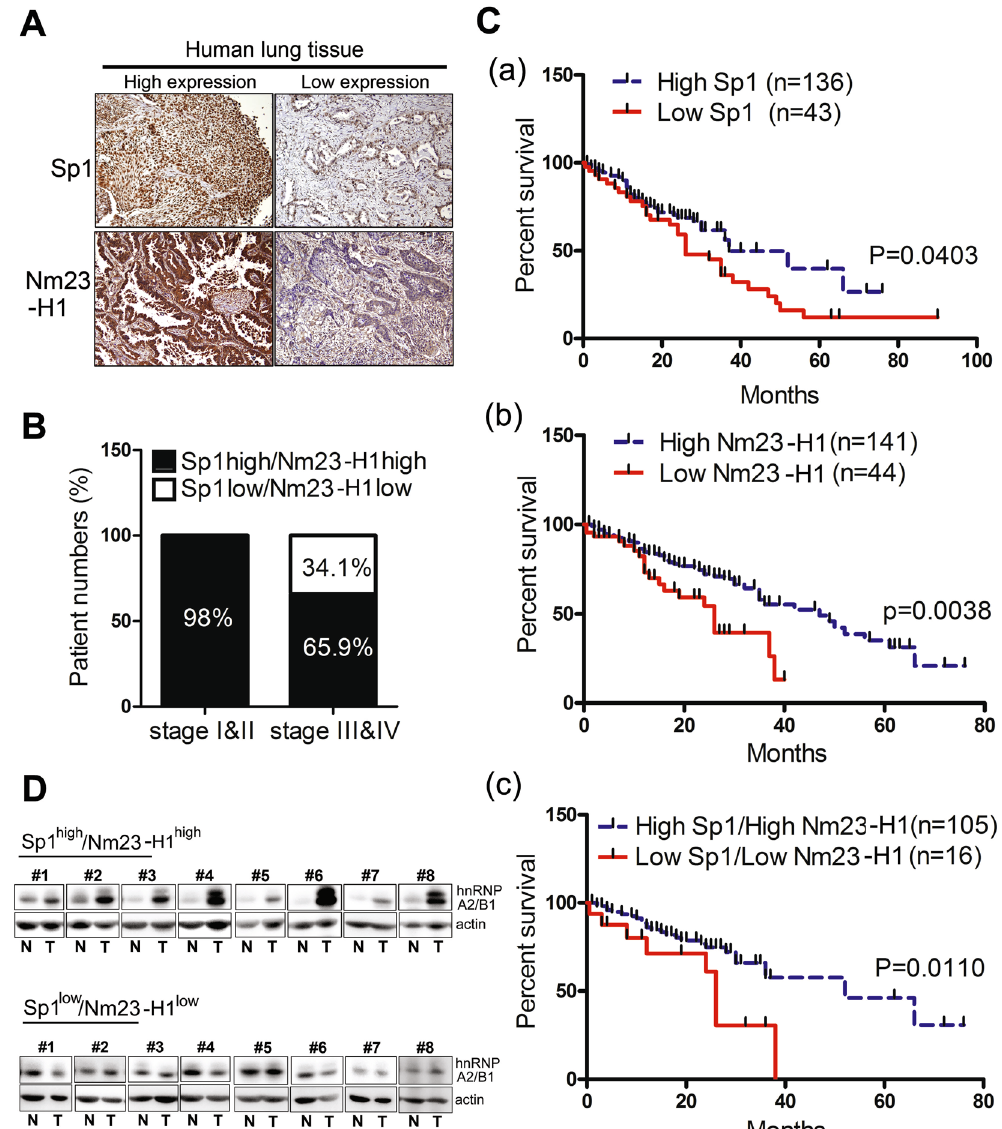
Figure 2. The relevance between Sp1/Nm23-H1 levels and the prognosis of lung cancer patients. ( A ) Samples from lung cancer patients were prepared for IHC staining with antibodies against Sp1 and Nm23-H1. ( B ) After IHC staining samples from 179 patients with anti-Sp1 antibodies and 185 patients with anti-Nm23-H1 antibodies, the relationship between Sp1/Nm23-H1 levels and the stage of lung cancer of the patients was analyzed. ( C ) The survival rate was analyzed between patients with higher Sp1 or lower Sp1 expression (a), patients with higher Nm23-H1 or lower Nm23-H1 expression (b), and between patients with higher Sp1/ Nm23-H1 or lower Sp1/Nm23-H1 expression (c) by Kaplan–Meier analysis. The P -value was determined by a two-sided log-rank test. ( D ). The level of hnRNPA2/B1 in the clinical samples with high levels of Sp1 and Nm23-H1 or with low levels of Sp1 and Nm23-H1 was studied by Western blotting with anti-hnRNPA2/B1